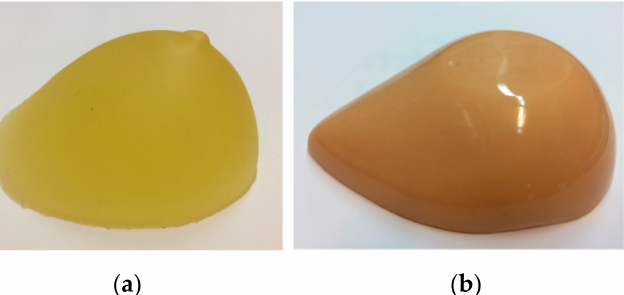
Figure 5. Breast phantoms used in measurements: ( a ) ATS Laboratories Model BB-1, ( b ) CSDS Blue Phantom Breast Masses.